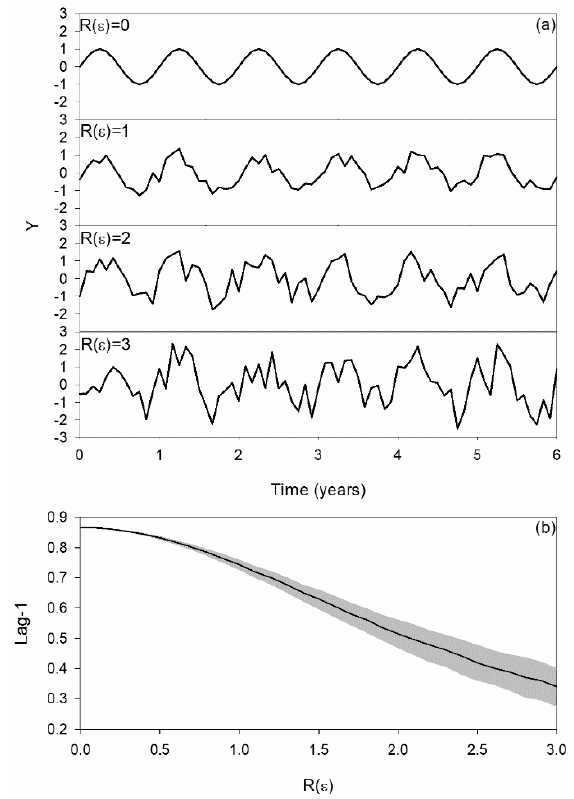
Figure 2. ( a ) Representation of Equation (2) with four selected ranges of the random variable ε. ( b ) Correlation coefficient for the lag-1 autocorrelation as a function of the range of the random variable ε . One thousand functions were proposed for each range. The median is presented in black, and the interquartile range is shown in grey.